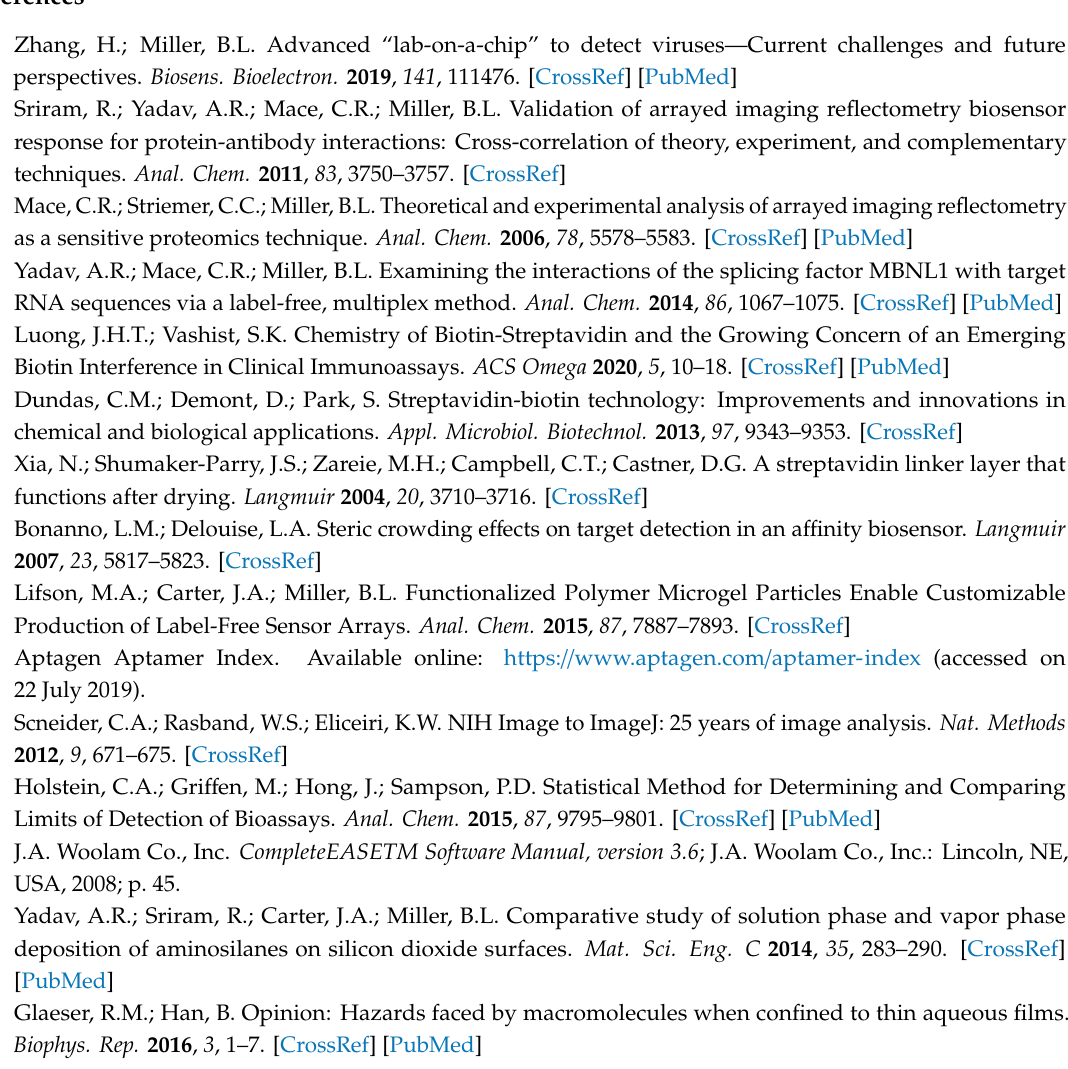
Figure S1: Growth and protection of the biotin-streptavidin surface for biotin-probe deposition, Figure S2: Schematic definition of the calculation of normalized thickness (Å) in AIR, Figure S3: Surface degradation and di ff erent protective coating mixtures, Figure S4: Arrays on chip surfaces containing di ff erent ratios of biotinylated and non-biotinylated linkers and streptavidin concentrations, Figure S5: Detection of thrombin protein using two di ff erent aptamer probes (29-mer and 15-mer), Figure S6: Probe layout for AIR images in Figures 4 and 5 (a), and Figure 6 (b), Table S1: Values used to calculate p-values for LOD comparisons, Video S1: Spin dry